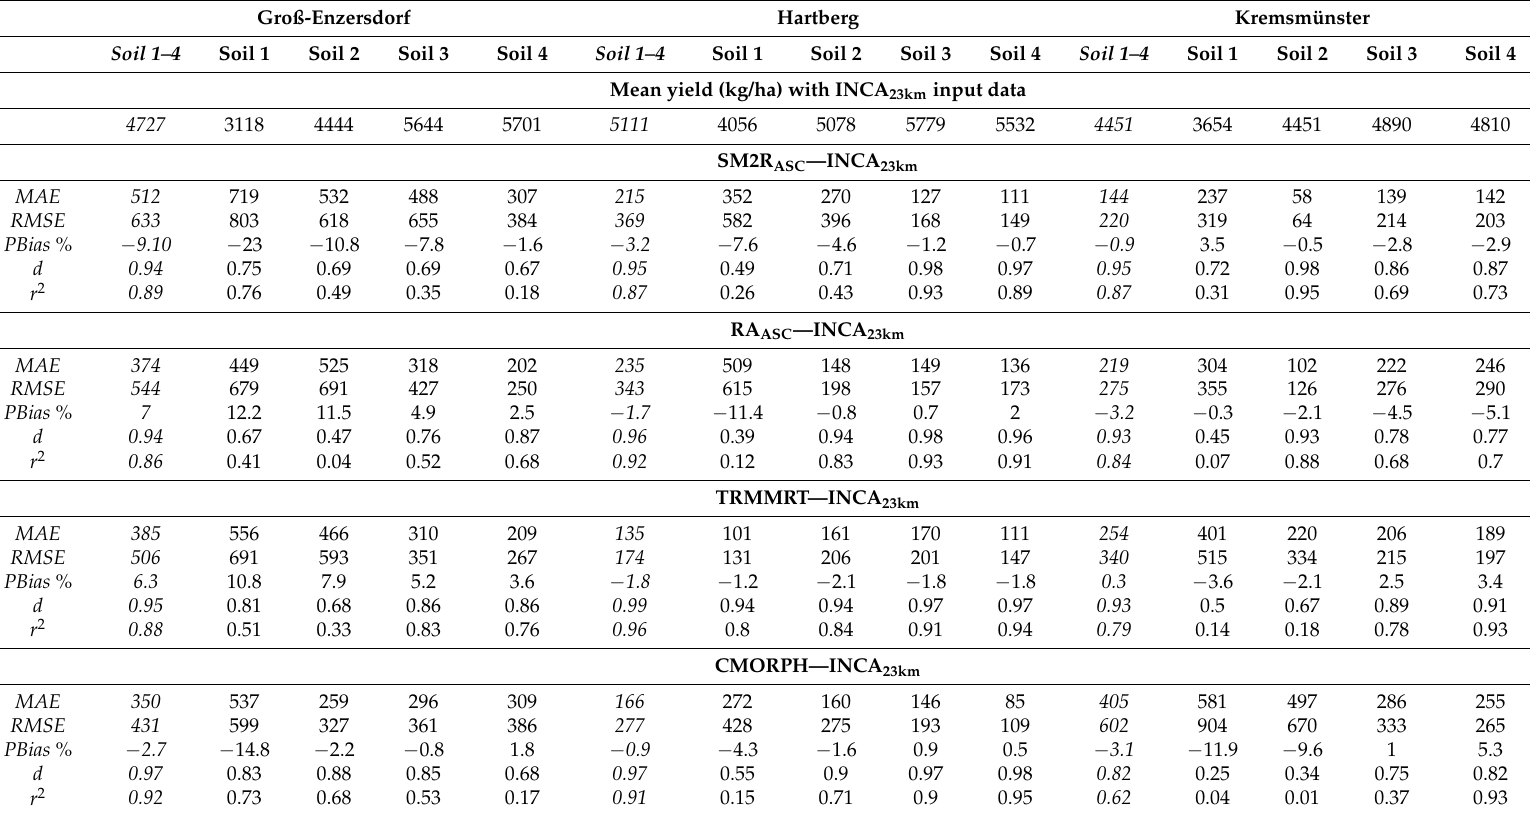
Table 6. Mean yield (kg/ha) with INCA 23km input data and comparative statistics ( MAE , RMSE , PBias , d and r 2 ) of model performance in simulated crop yield using SM2R ASC , RA ASC , TRMMRT, and CMORPH precipitation inputs against INCA 23km inputs for the three study areas—spring